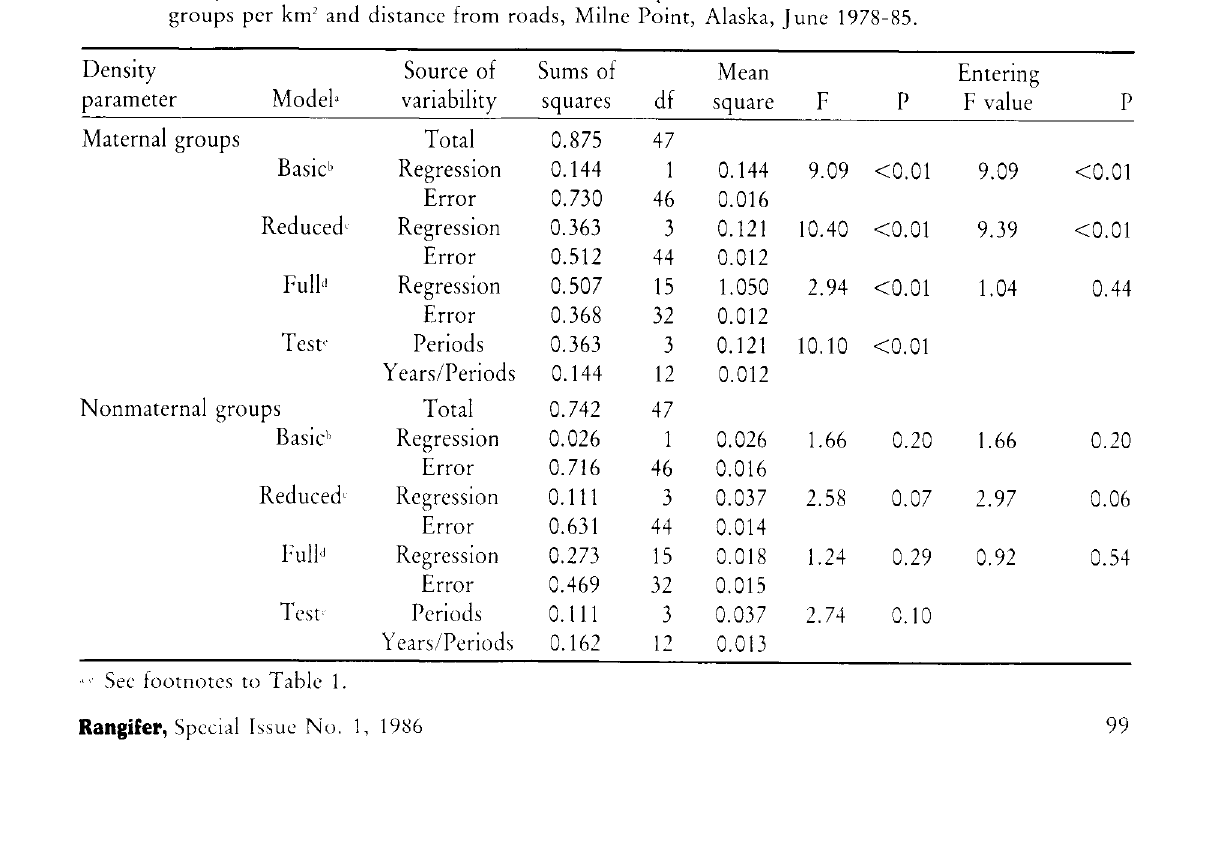
Fig. 3. The relationships between caribou density and distance from roads for all caribou, and calves (i.e., neonates), during June 1978 — 81 and 1982 - 85, Milne Point, Alaska. Data points shown are strata means for each 4-year period; however, linear models were fit using data for individual years.